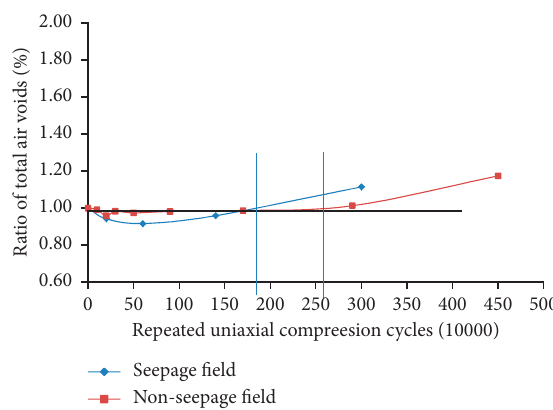
Figure 13: Relationship between repeated uniaxial compression cycles and ratio of total air voids.